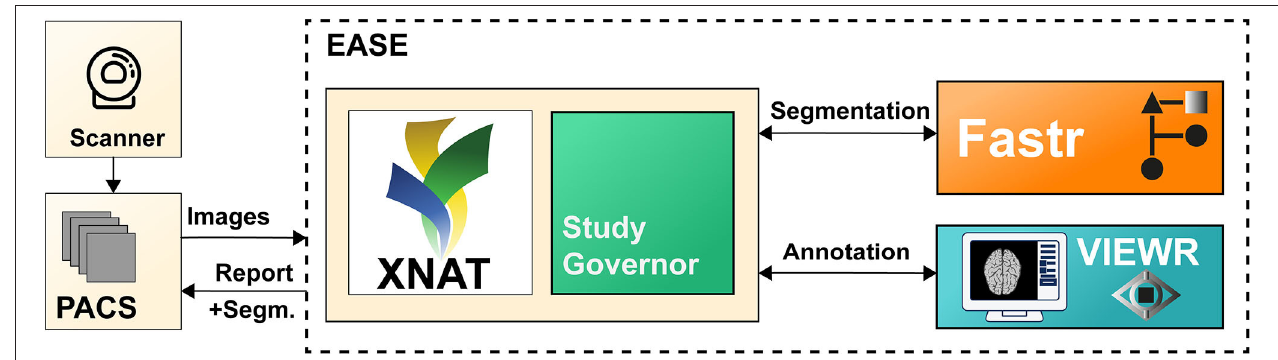
FIGURE 1 | Illustration of the different components of EASE. Images are sent from the PACS and added to the XNAT (9) database. The data and state manager (Study Governor) triggers the processing using Fastr (10). After successful processing, the results can be checked in the VIEWR. A report, including the delineations, is sent back to the